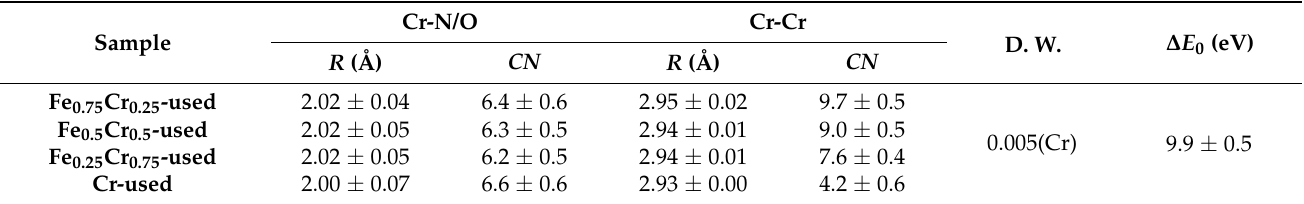
Table 5. Cr K-edge EXAFS fitting results of used FeCrO x catalysts a .